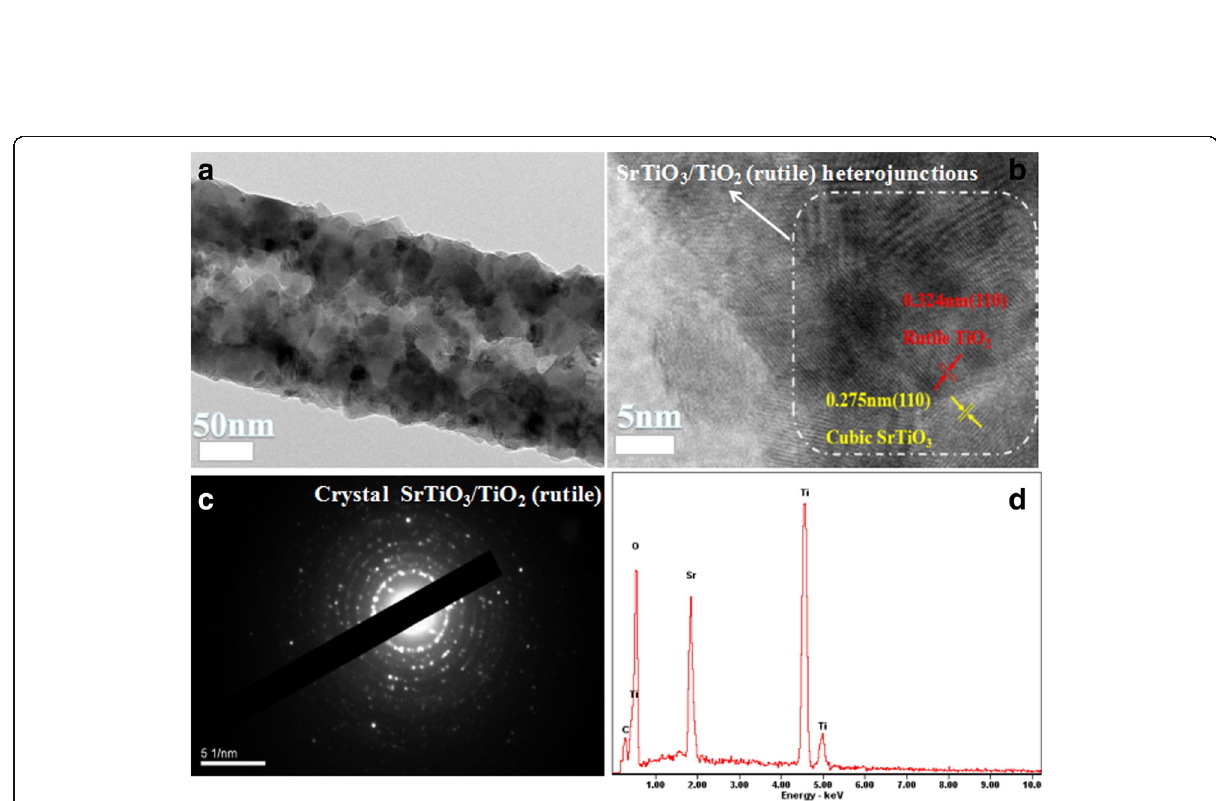
Fig. 4 TEM image and EDS spectrum of ST-3. a TEM image of ST-3, ( b ) HRTEM of the delineated area of the rutile TiO 2 and SrTiO 3, ( c ) SAED of ST- 3, ( d ) EDS of